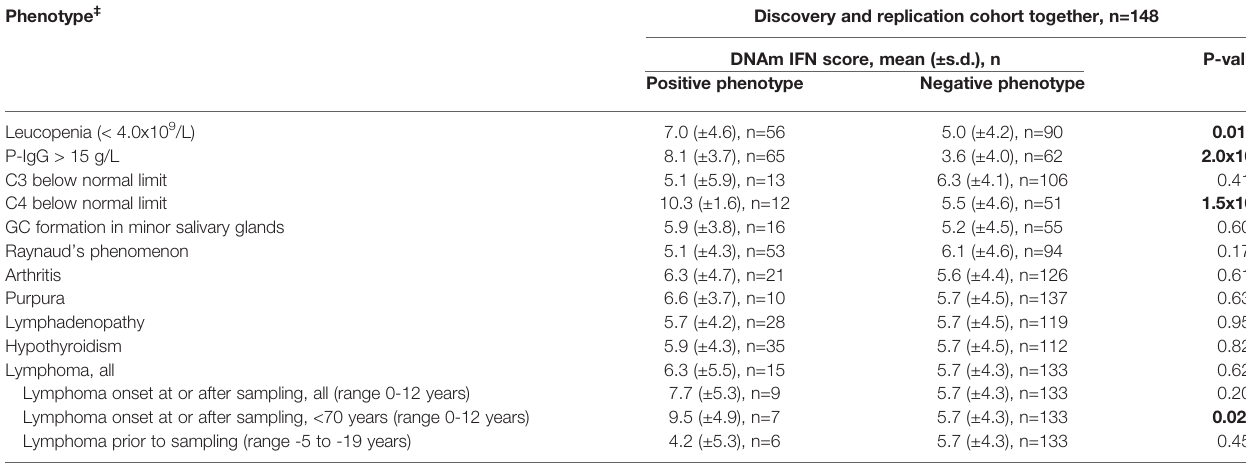
TABLE 3 | Association between DNA methylation-based IFN score level and clinical manifestations of primary Sjögren ’ s syndrome (pSS).